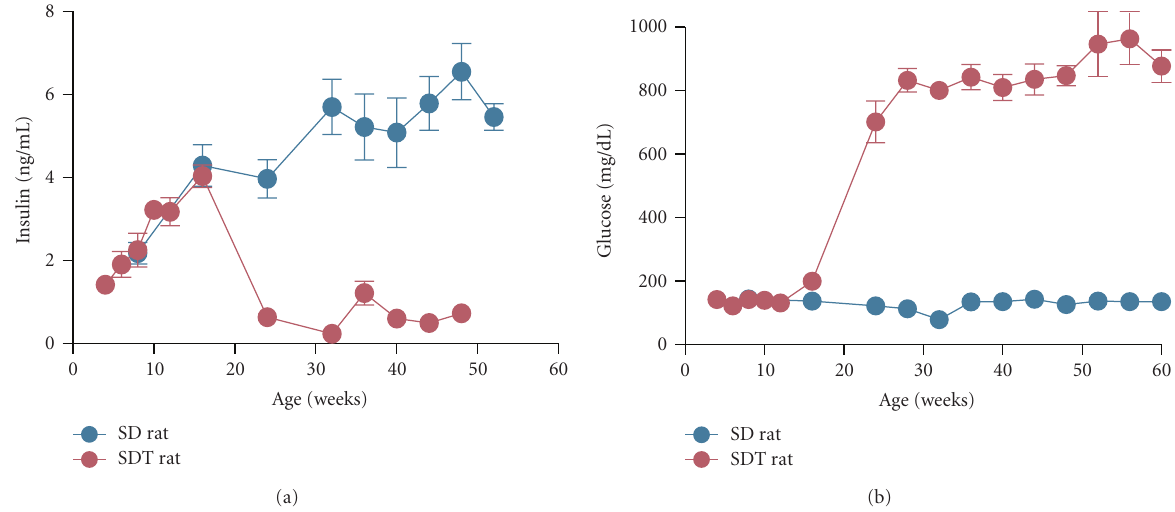
Figure 1: Nonfasting plasma insulin and glucose levels in Spontaneously Diabetic Torii (SDT) rats and control Sprague-Dawley (SD) rats. Diminish of pancreatic β -cells evokes hypoinsulinemia (a) and subsequent severe hyperglycemia (b) in SDT rats. Plasma glucose levels sharply increase at 15–20 weeks of age and eventually reach a plateau, approximately 800mg/dL. Each value represents mean ± S.E.M. ( N =